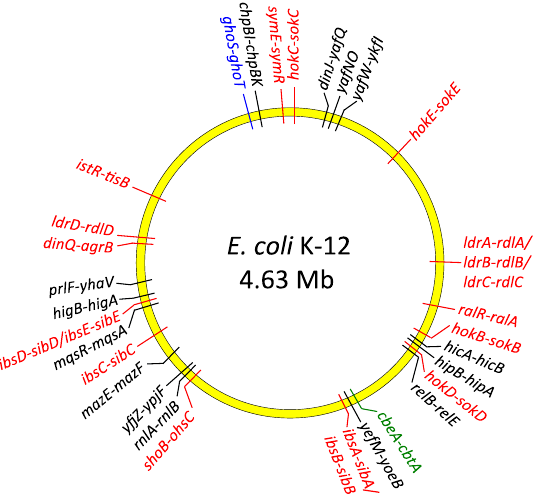
Figure 2. Distribution of type I (red), type II (black), type IV (green) and type V (blue) TA genes on the chromosome of E. coli K-12.